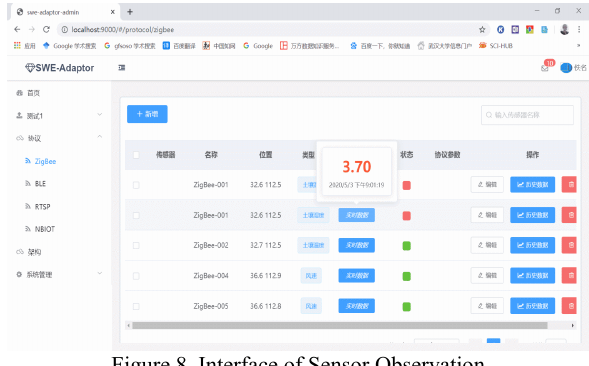
Figure 8. Interface of Sensor Observation